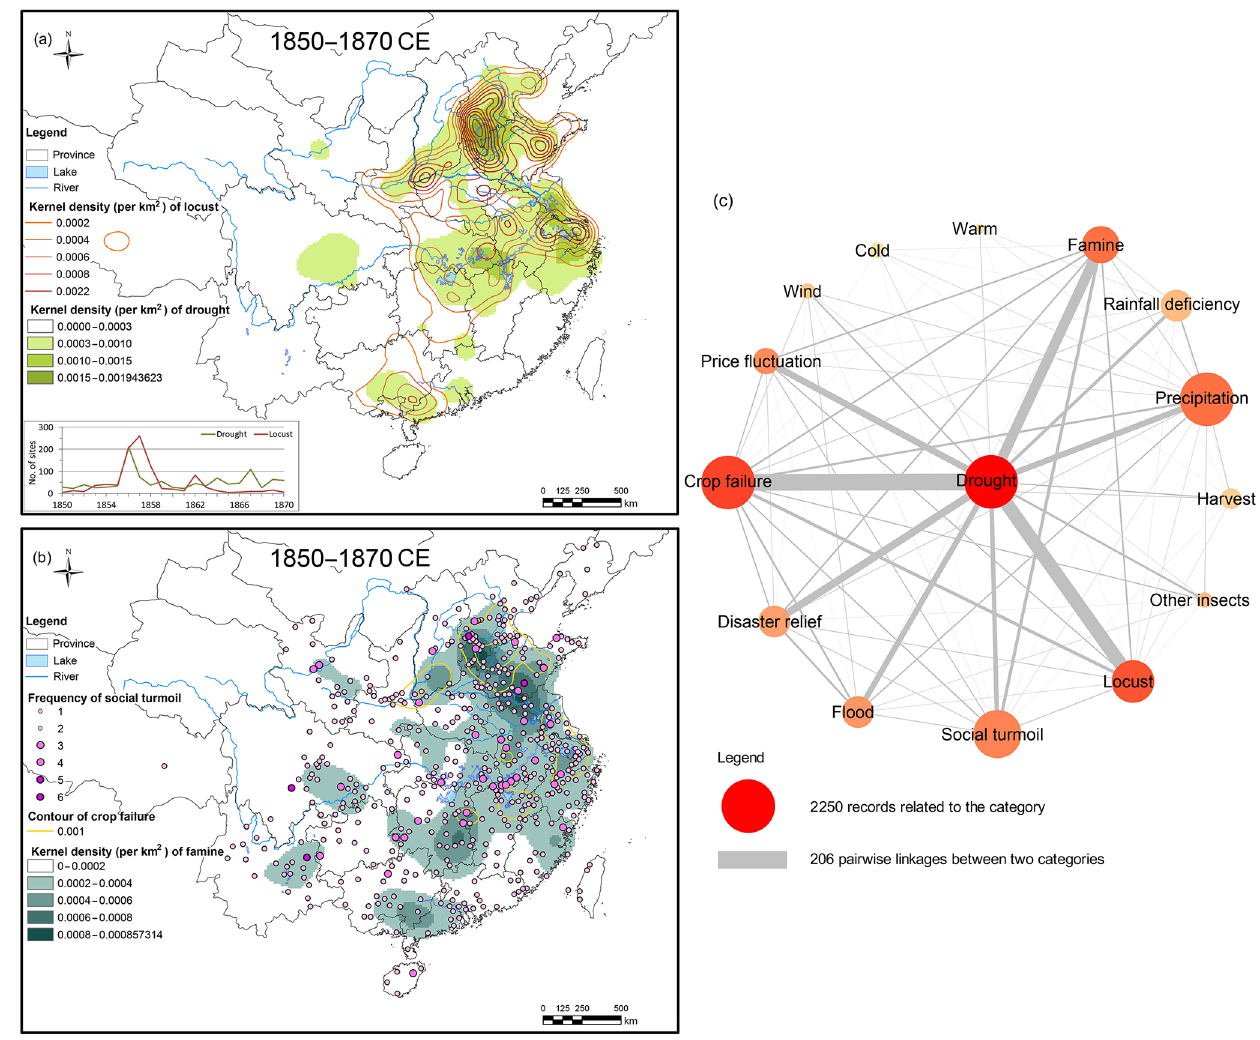
Figure 11. Spatial distribution of the kernel density function of drought and locust outbreaks (a) and social turmoil (b) , and the social network chart (c) in the drought period